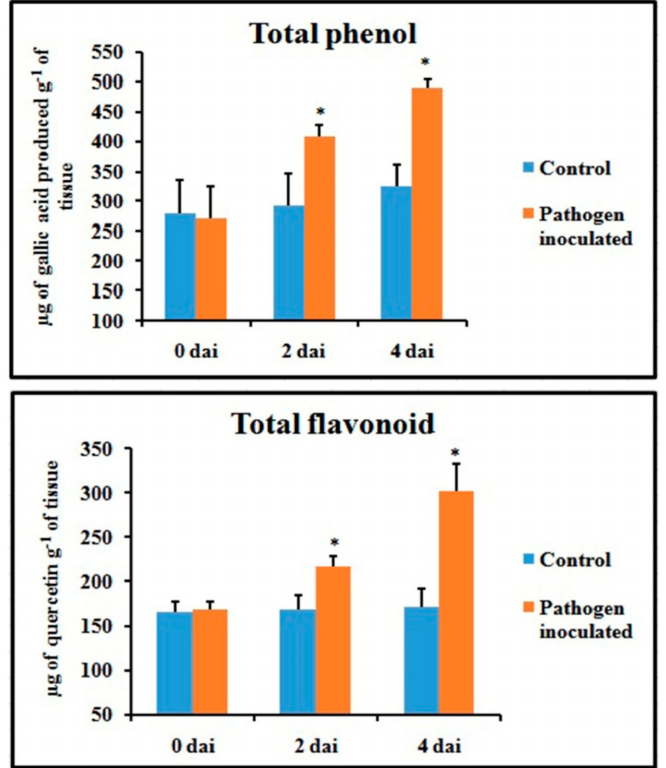
Figure 5. E ff ect of C. gloeosporioides on on the production of total phenols and flavonoids in detached bean leaf. Values represent mean ± SD of three separate experiments, each in triplicate. * Significant di ff erence between pathogen-inoculated and control sets at P < 0.05